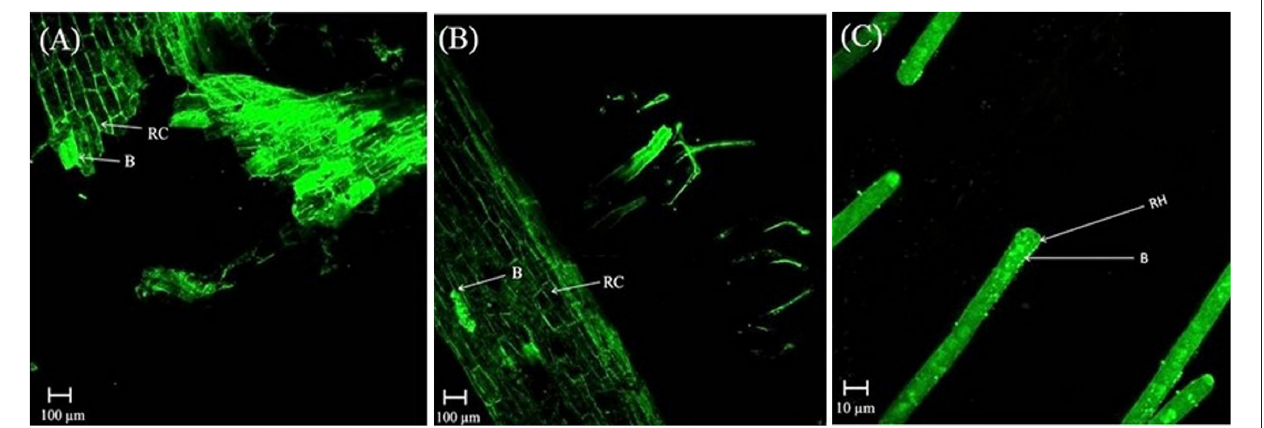
FIGURE 5 | Confocal microscopic image of potato root inoculated with YFP-labeled Azospirillum sp. TN09 in sterilized sand after 25 days. Bacterial cells forming thick macro-colonies of Azospirillum sp. TN09 were observed over the potato root surface (A,B) . Root lateral area and hair tips were the preferred sites of Azospirillum sp. TN09 colonization shows the association of TN09 strain with potato roots (C) . RC, Root cell; RH, Rhizosphere; B, Bacterium.